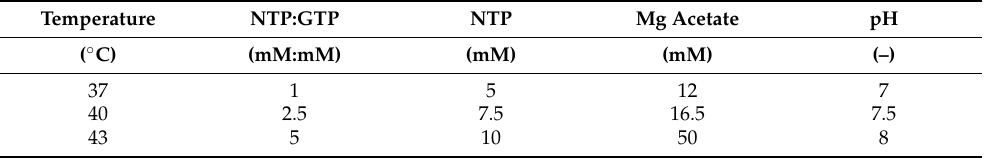
Table 1. Factors varied in the DoE and their studied ranges.